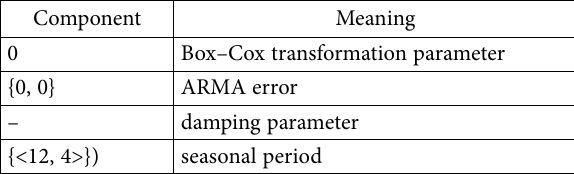
Figure 3. ETS (AAA) forecast Figure 4. TBATS forecast Table 3. Parameters of TBATS model (0, {0, 0}, –, {<12, 4>}) Table 4. Estimates of parameters of ARIMA